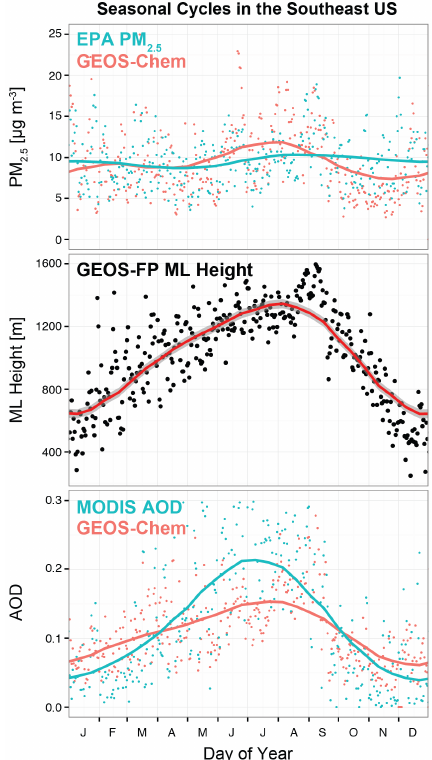
Figure 12. Seasonal aerosol cycle in the southeast US in 2013. Top: daily mean EPA and GEOS-Chem PM 2 . 5 . Middle: daily maximum mixed layer height from GEOS-FP with 40% downward correction applied year-round as in GEOS-Chem (see Sect. 2). Bottom: daily mean AOD from MODIS and GEOS-Chem. GEOS-Chem results in this figure are from the coarse-resolution (4 ◦ × 5 ◦ ) global sim- ulation for 2013. Smoothed curves are calculated using a low-pass filter. All values are averaged over the southeast US as defined in Fig.